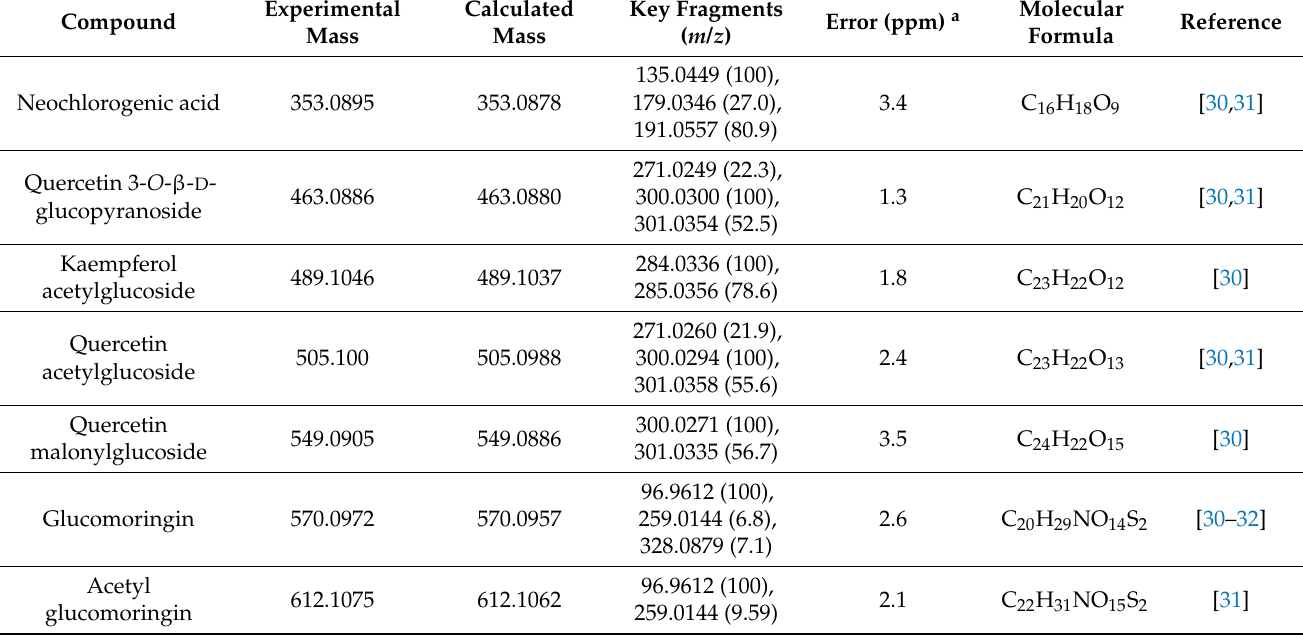
Table 1. Tentative compounds identified in water extract of M. oleifera leaves from Barletta (MLEB) by HRMS under negative ([M − H] – ) ionization.